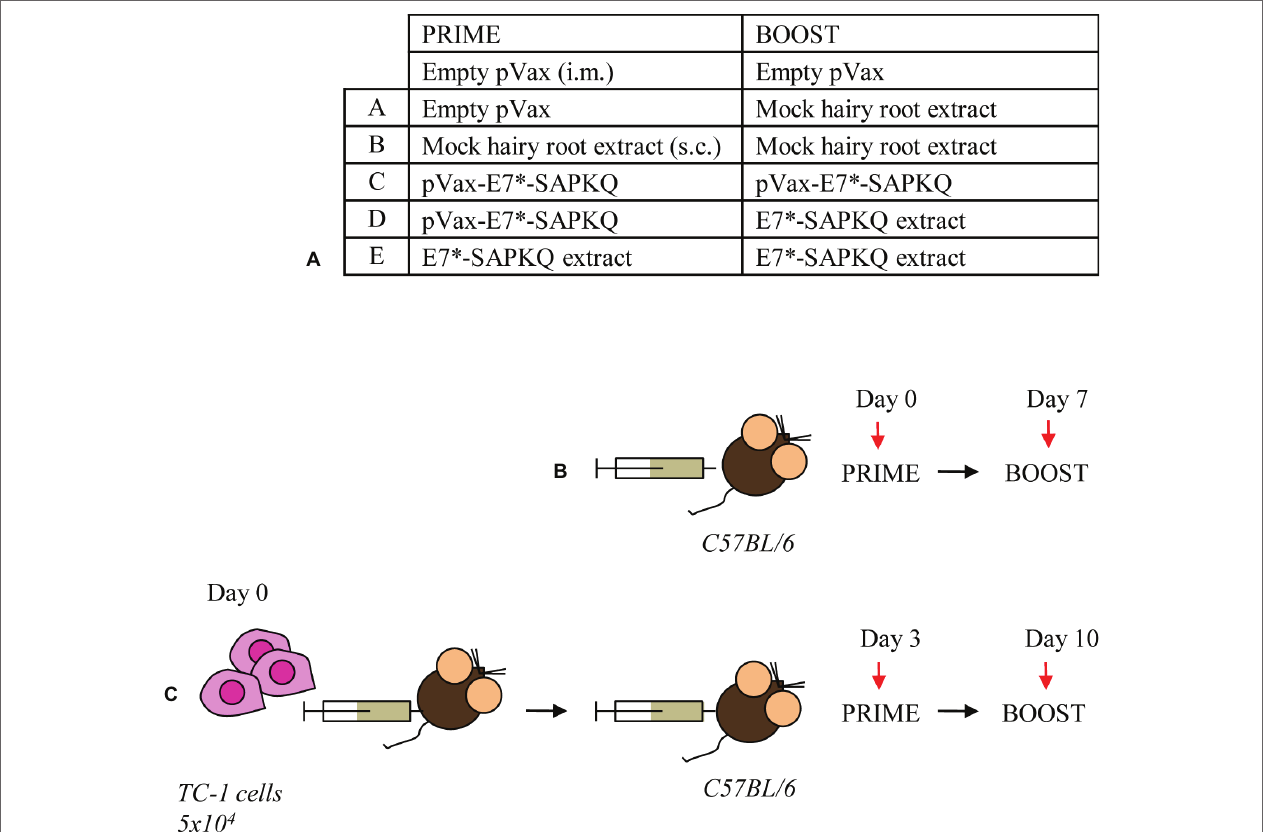
FIGURE 6 | Immunization schedules. (A) Prime/boost regimens. A, empty pVax prime/mock hairy root extract boost; B, mock hairy root extract prime/mock hairy root extract boost; C, pVax-E7*-SAPKQ prime/pVax-E7*-SAPKQ boost; D, pVax-E7*-SAPKQ prime/E7*-SAPKQ extract boost; E, SAPKQ extract prime/SAPKQ extract boost. (B) Immunization of mice in the absence of tumor challenge or (C) in the presence of tumor challenge to evaluate immune response and tumor rejection,